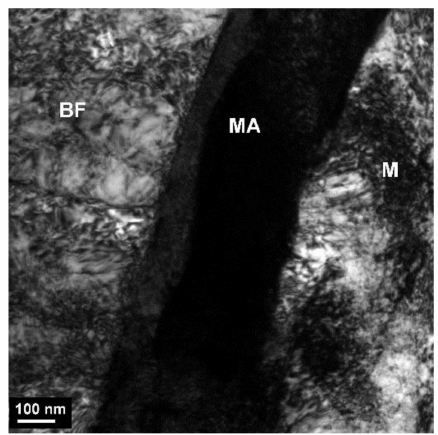
Figure 8. The magnified image showing the fine structure of the grain boundary MA constituent corresponding to the zone squared in Figure 7 (BF: bainite ferrite, MA: grain boundary MA constituent, M: martensite that transformed from remaining austenite of neighboring